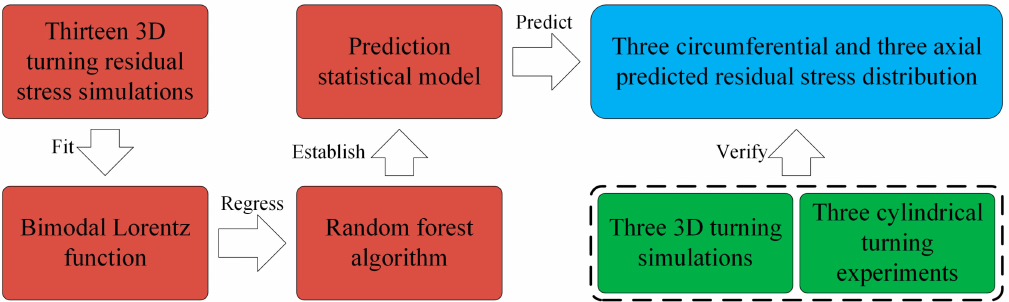
Figure 1. The main steps of residual stress